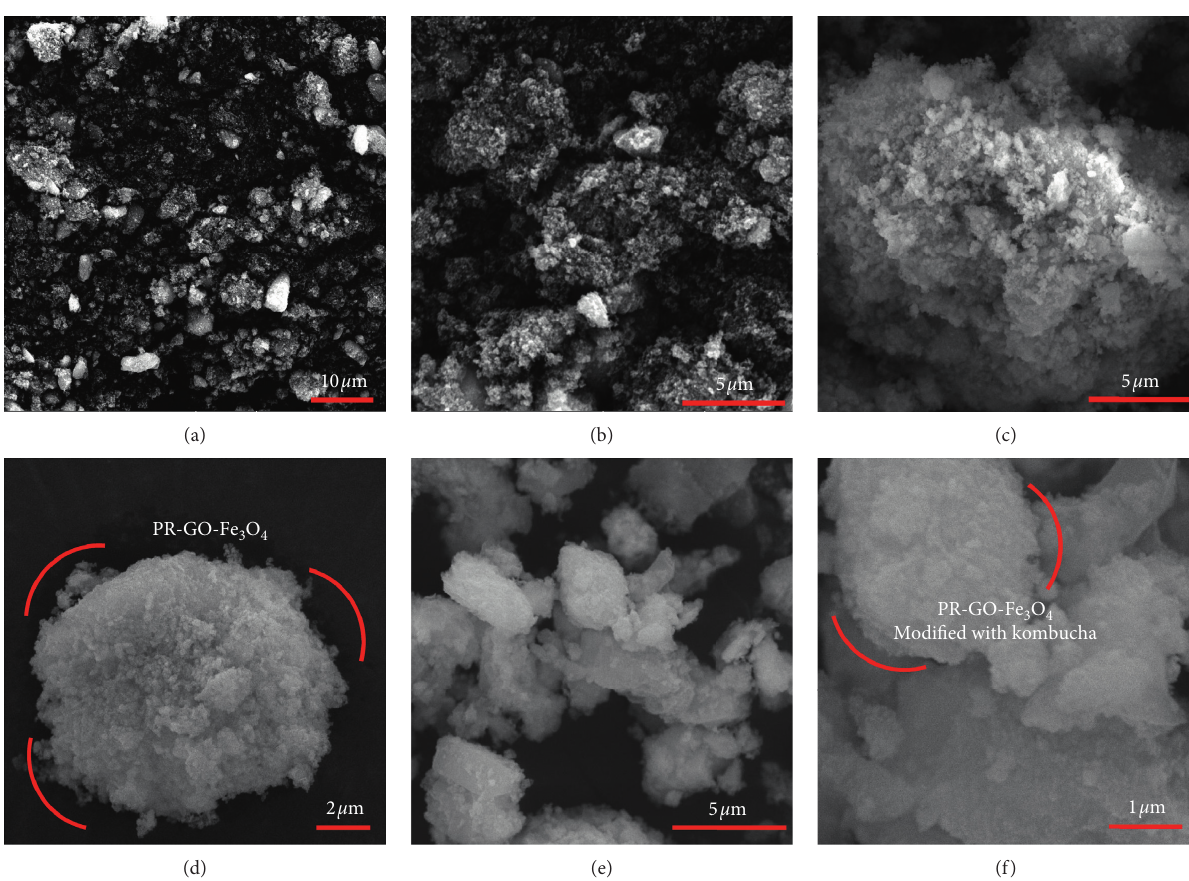
Figure 4: SEM images of ((a), (b)) PR-Fe 3 O 4 , ((c), (d)) PR-GO-Fe 3 O 4 , and ((e), (f)) modified PR-GO-Fe 3 O 4 with kombucha